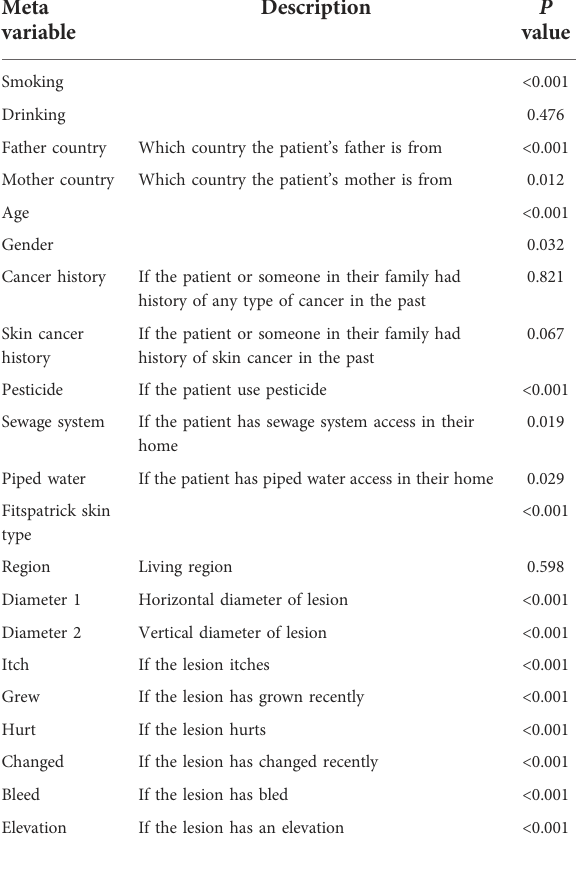
TABLE 1 Description of attributes in meta